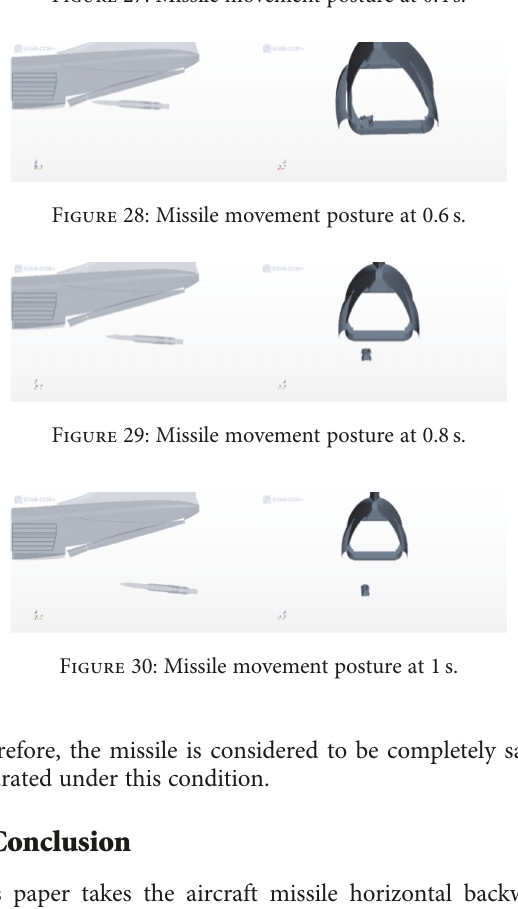
Figure 27: Missile movement posture at 0.4s.